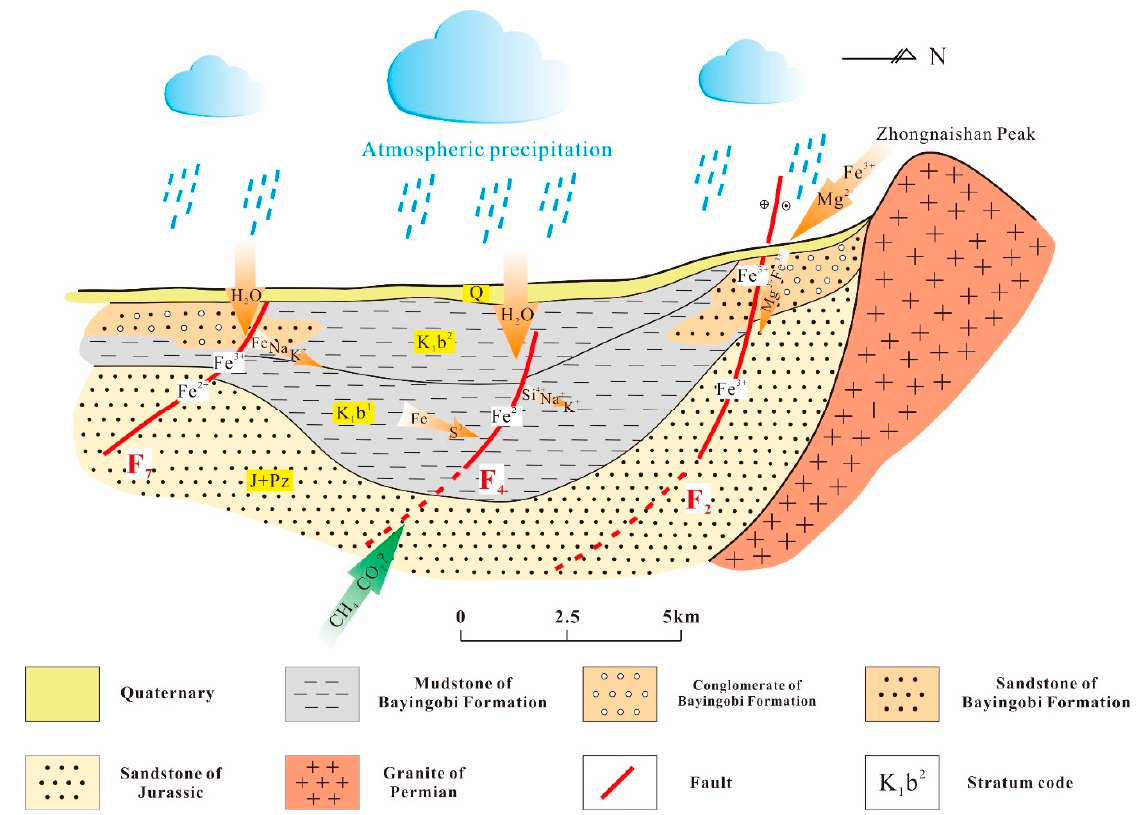
Figure 7. Conceptual diagram showing the features of the three study